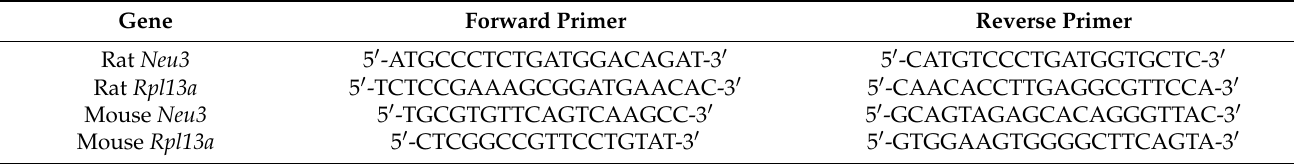
Table 1. qPCR primers